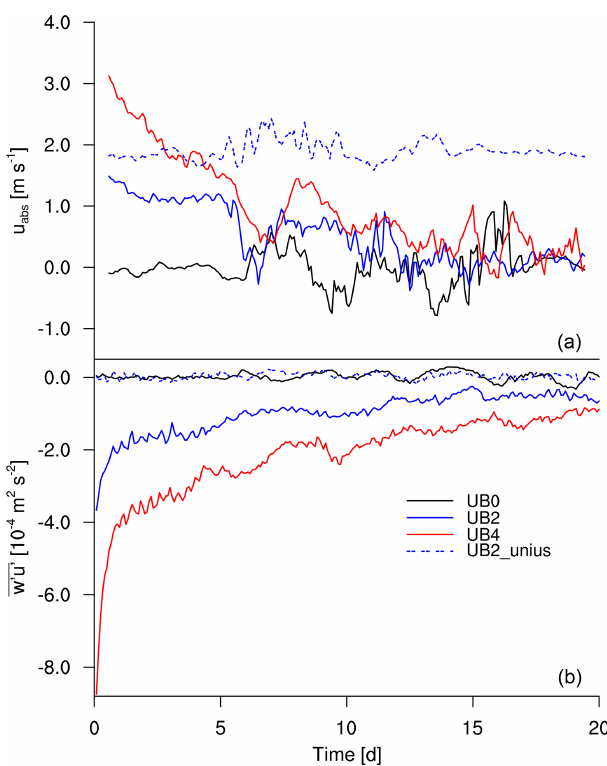
Figure 2. Temporal evolution of (a) u abs in the x direction and (b) domain-averaged w (cid:48) u (cid:48) at the surface. Day 0 corresponds to the day when u b begins to be